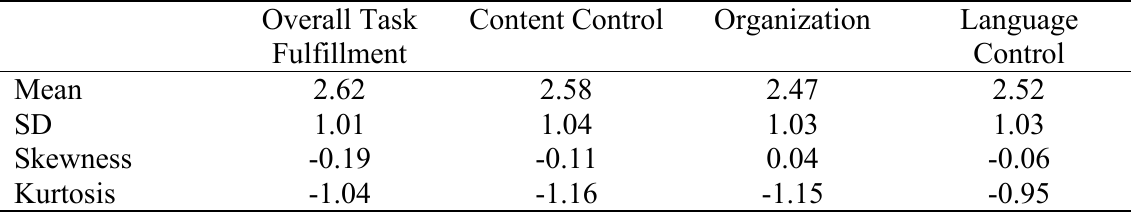
Descriptive Statistics of Scoring in Each